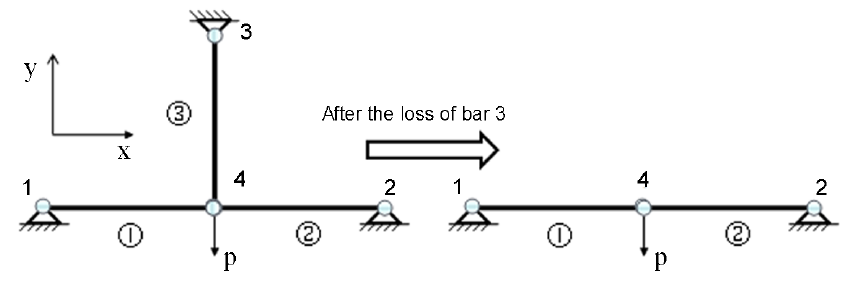
Fig. 6. A three-bar pin-jointed